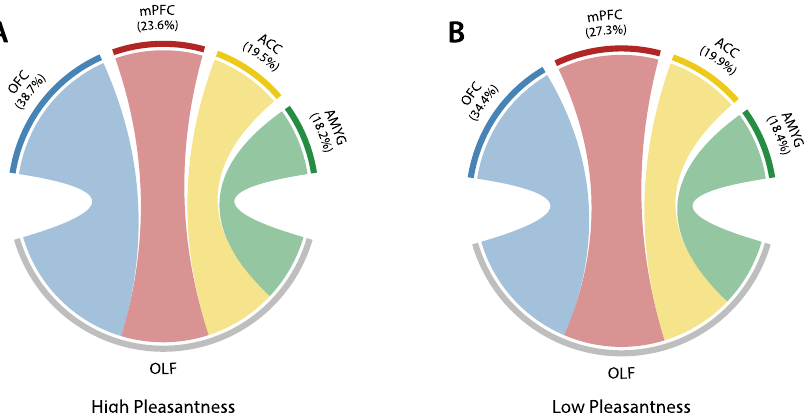
Figure 5. Chord diagrams outlining normalized connectivity preferences of the olfactory cortex (OLF) to regions included in the proposed hedonic evaluation model (consisting of OFC, mPFC, OLF, ACC, AMYG), for high- (panel A ) and low pleasantness (panel B ) stimuli. Only the beta band ([13–30] Hz) was considered.